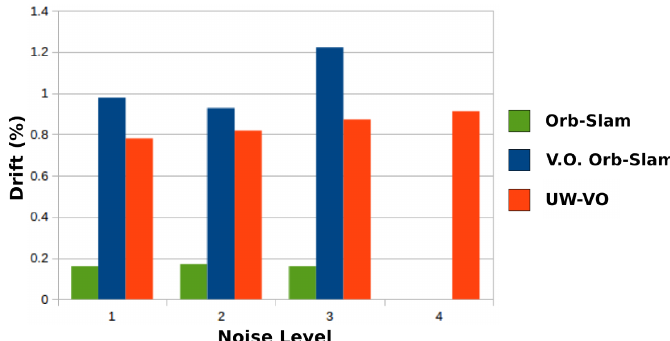
Figure 6. The four different turbidity levels of the simulated dataset.